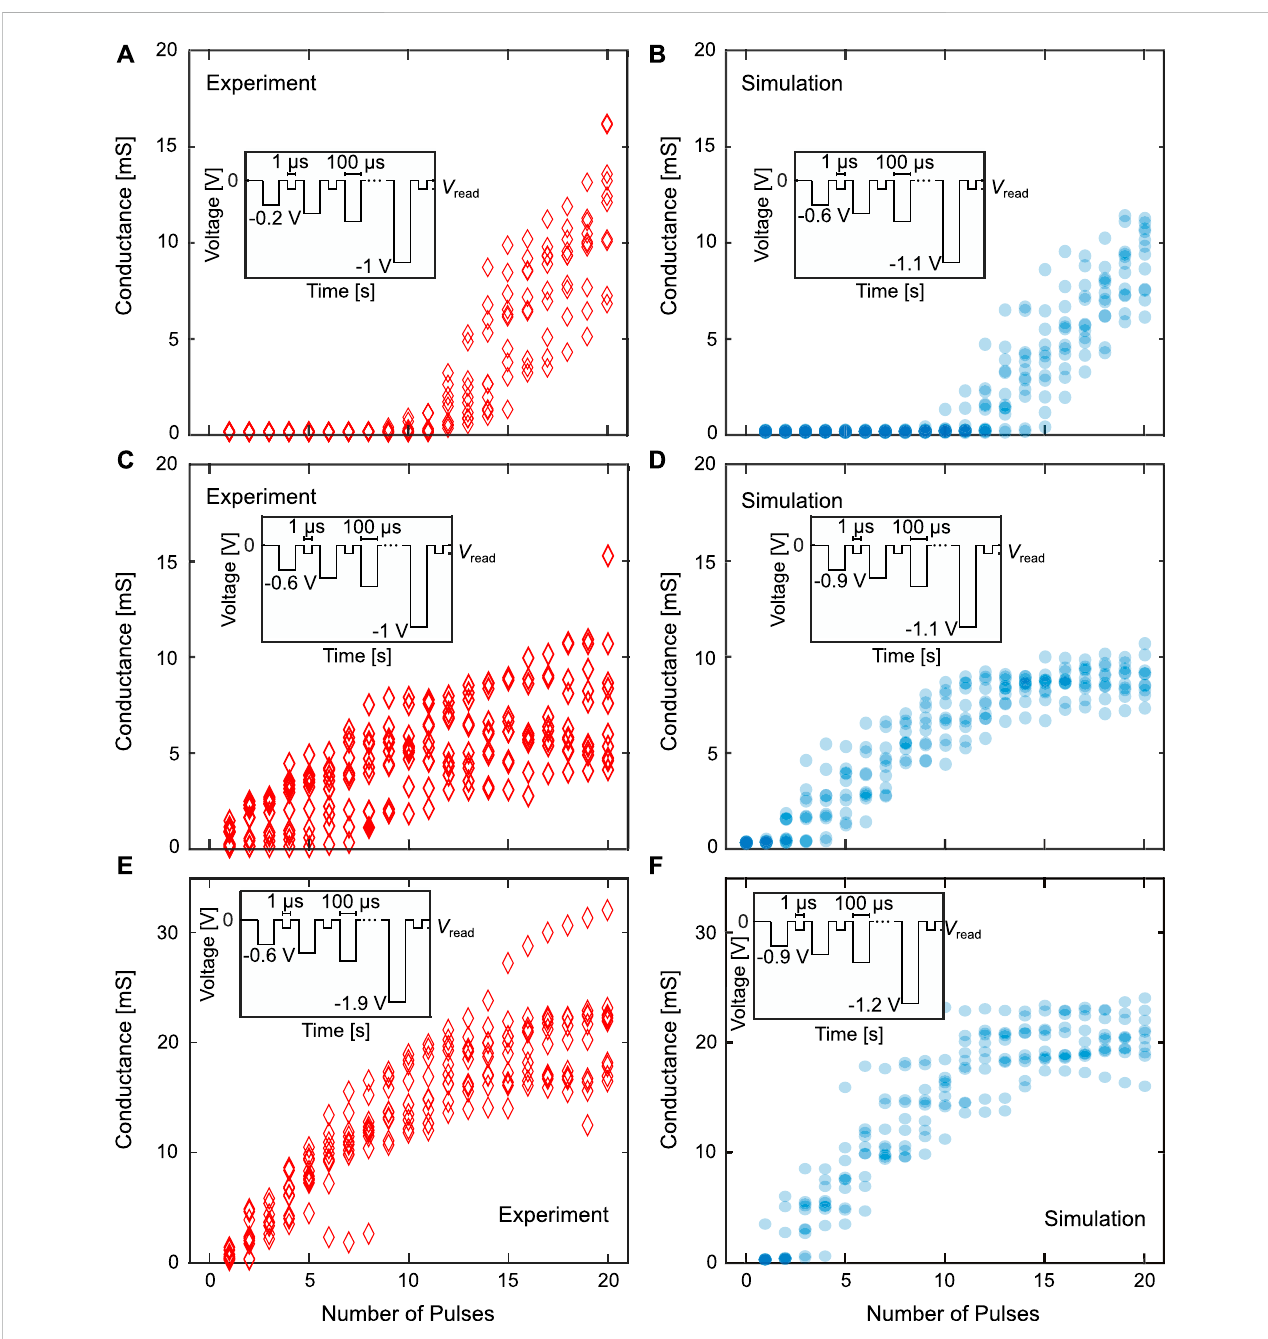
pulse schemes with the applied voltages and pulse